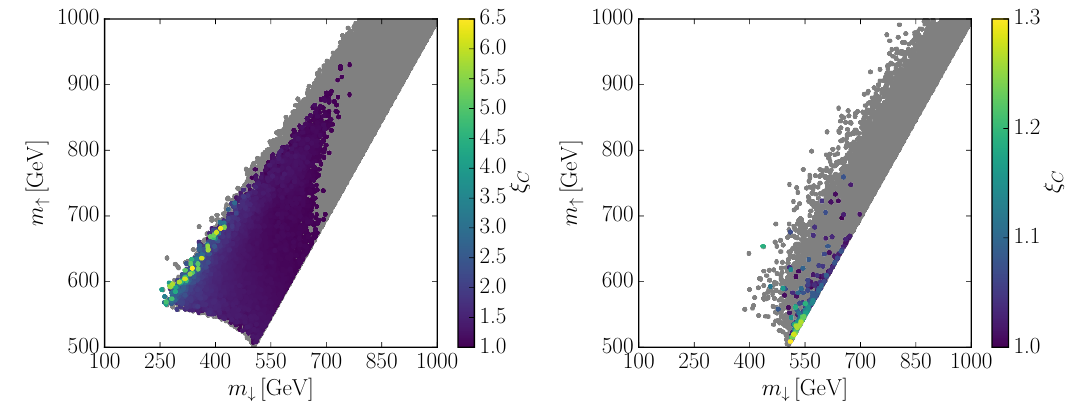
Figure 13 . Type II, H 1 = h : the mass of the heavier versus the lighter non-SM-like Higgs boson. Left: CP-conserving and CP-violating points, right: only CP-violating points. Grey: points